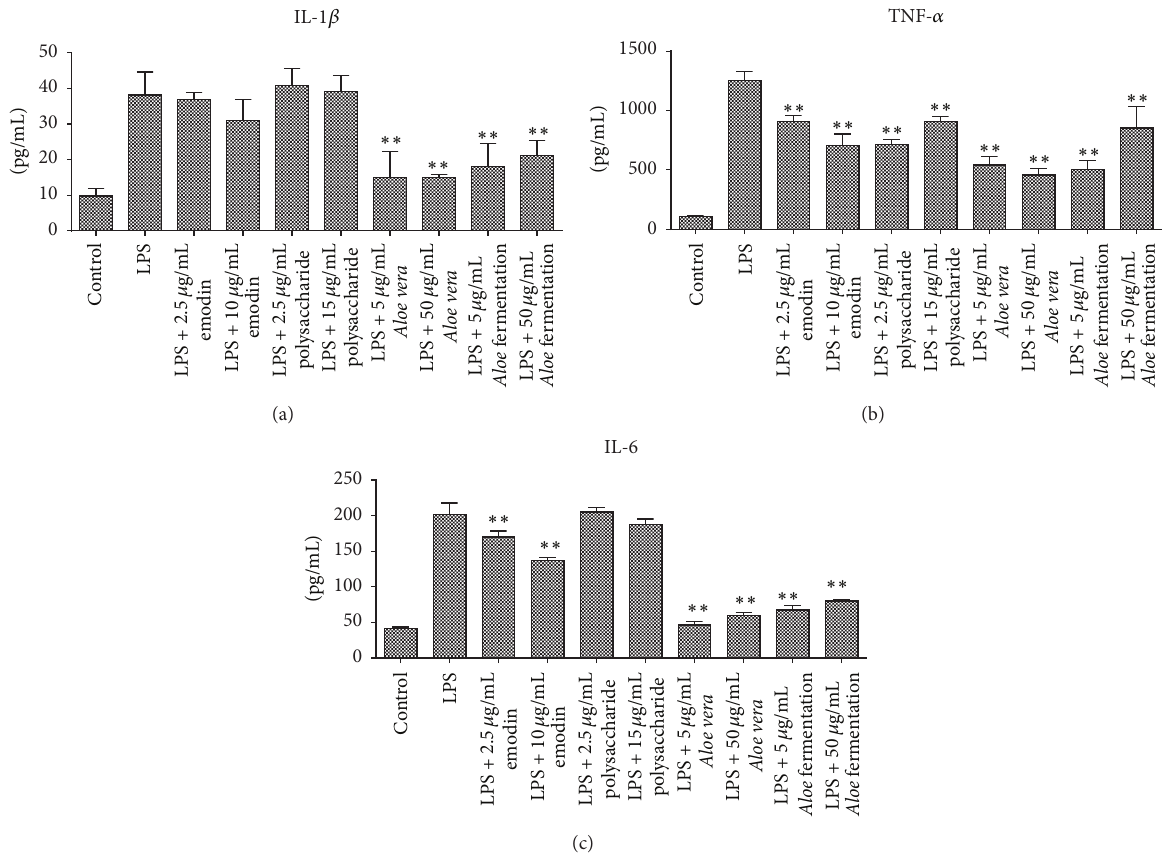
Figure 5: Effect of the different concentrations of emodin, polysaccharide, Aloe vera , and fermentation broth on the protein yields of IL-1 𝛽